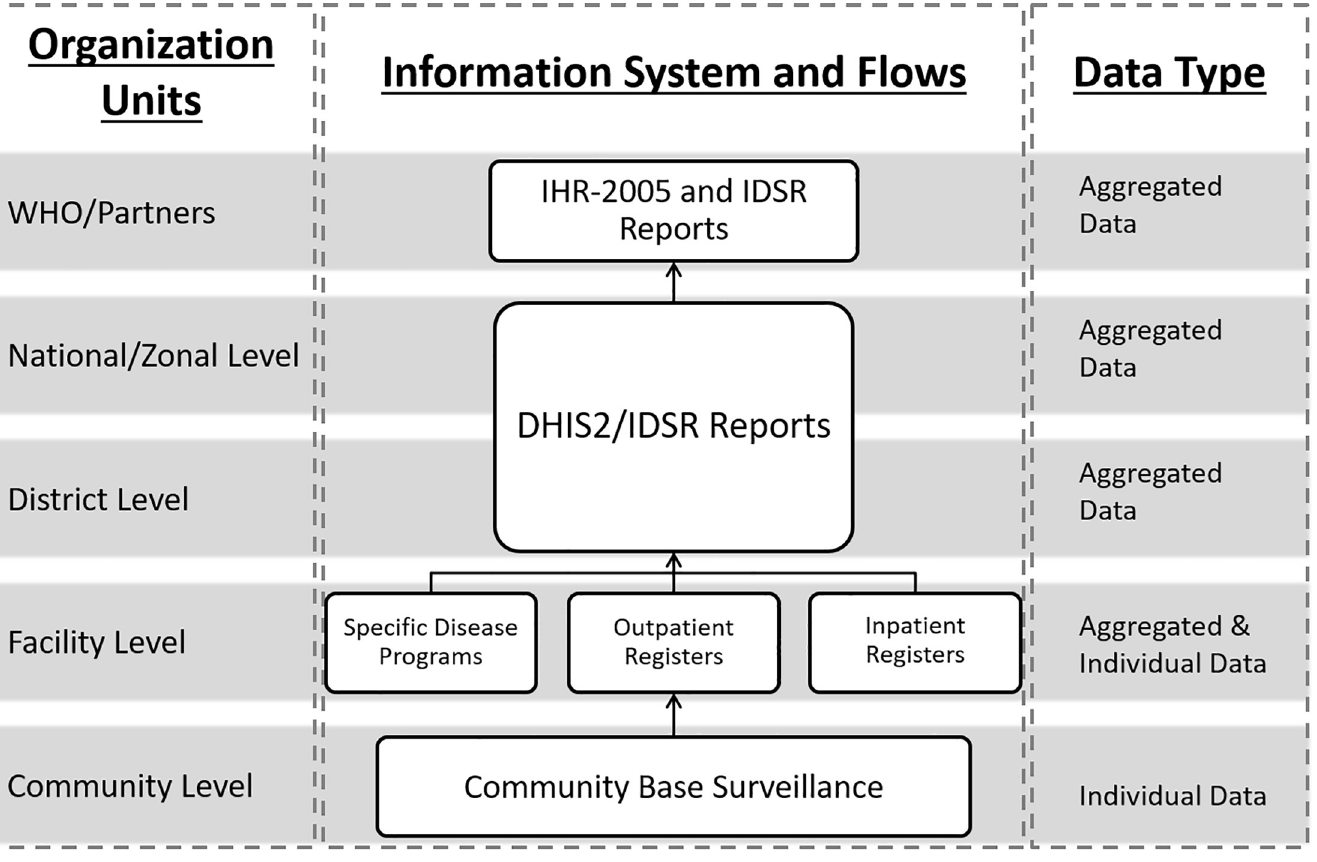
Fig 1. The IDSR system information flow according to the organization architecture in